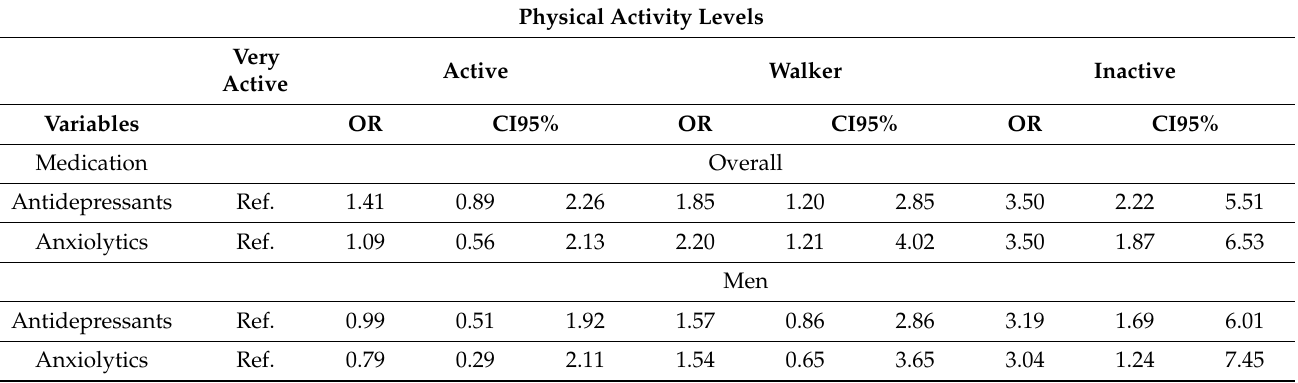
Table 3. Antidepressant or anxiolytic use risks according to the Physical Activity Level in Spanish people with Hypertension